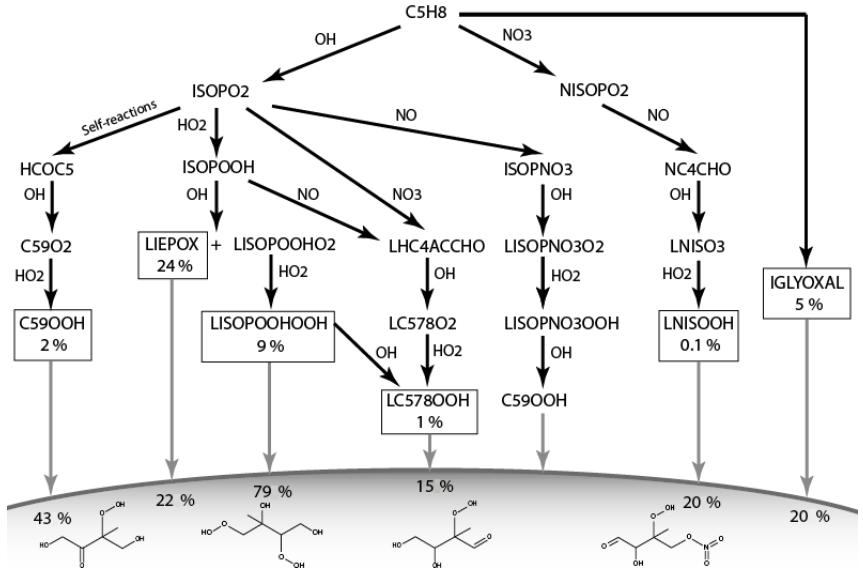
Figure 1. Simplified overview of chemical pathways leading to sufficiently low-volatile isoprene-derived compounds able to partition into the aerosol phase. Note that ISOPO2 is used here for simplicity; JAM3 includes three different ISOPO2s (LISOPACO2, ISOPBO2, ISOPDO2), and the same applies for ISOPOOH. The percentages in the boxes indicate average mass yields and thus the annual mean reaction turnover of isoprene leading to these products. For IGLYOXAL there are too many formation pathways and they are therefore not shown. The solid horizontal curve represents the boundary to the particle phase. Percentages found under the corresponding arrow express the annual mean individual net iSOA yield of the compound. Except for LIEPOX and IGLYOXAL, structures are relevant to estimate the saturation vapor pressure and evaporation enthalpy and are therefore shown here. For the detailed mechanism, the reader is referred to Schultz et al.